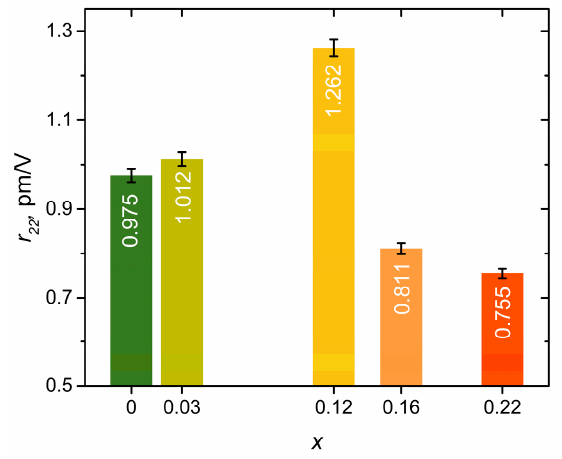
Figure 7. Estimated electro-optic coefficient r 22 of GaSe:S crystals. The absolute measurement error of the electro-optical coefficient is estimated to be about 10 − 3 pm/V.